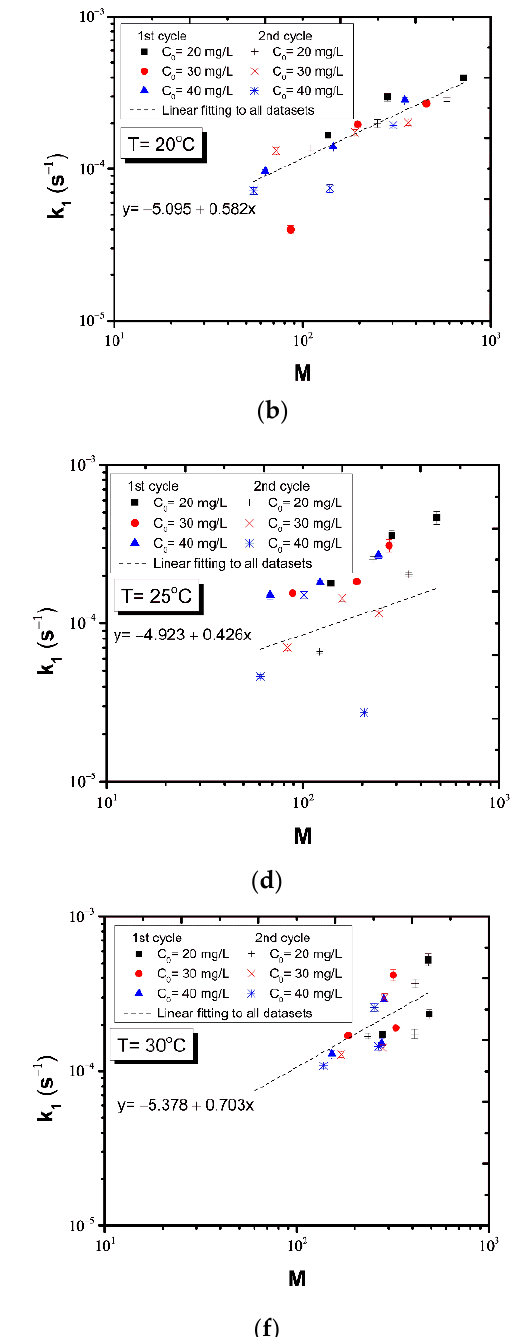
( b ) Figure 9. The percentage of ZnO mass detached from Duranit balls after the ( a ) 1st and ( b ) 2nd cycle of photocatalysis. It is evident that the kinetic constant decreases weakly when the photocatalyst is re- used and some of its mass has been detached, while no significant effect of the tempera- ture on 𝑘 (cid:2869) value was realized (Figure 10). A linear regression analysis was conducted for the pseudo-first order kinetic constants estimated from tests conducted at each tempera- ture with regard to the initial phenol concentration (Figure 10a,c,e) and ratio M of catalyst mass to the initial phenol mass (Figure 10b,d,f). The results of k 1 vs. C 0 were classified into datasets according to the initial mass of photocatalyst and cycle of photocatalysis and plotted on a log scale (Figure 10a,c,e). The slope of the linear regression can be used as a quantitative criterion to assess the distance of the overall reaction rate from a 1st order process. Approximately, the order 𝑚 of the overall process could be extracted from the exponent of the scaling law 𝑘 (cid:2869) ∝ 𝐶 (cid:2868)(cid:3040)(cid:2879)(cid:2869) (13) Given that 𝑚 − 1 < 0 (Table 4, Figure 10a,c,e), it turns out that 𝑚 < 1 , namely that the overall photocatalytic reaction deviates from a 1st order process. Regardless of the catalyst mass and cycle of photo-degradation tests, all datasets ob-